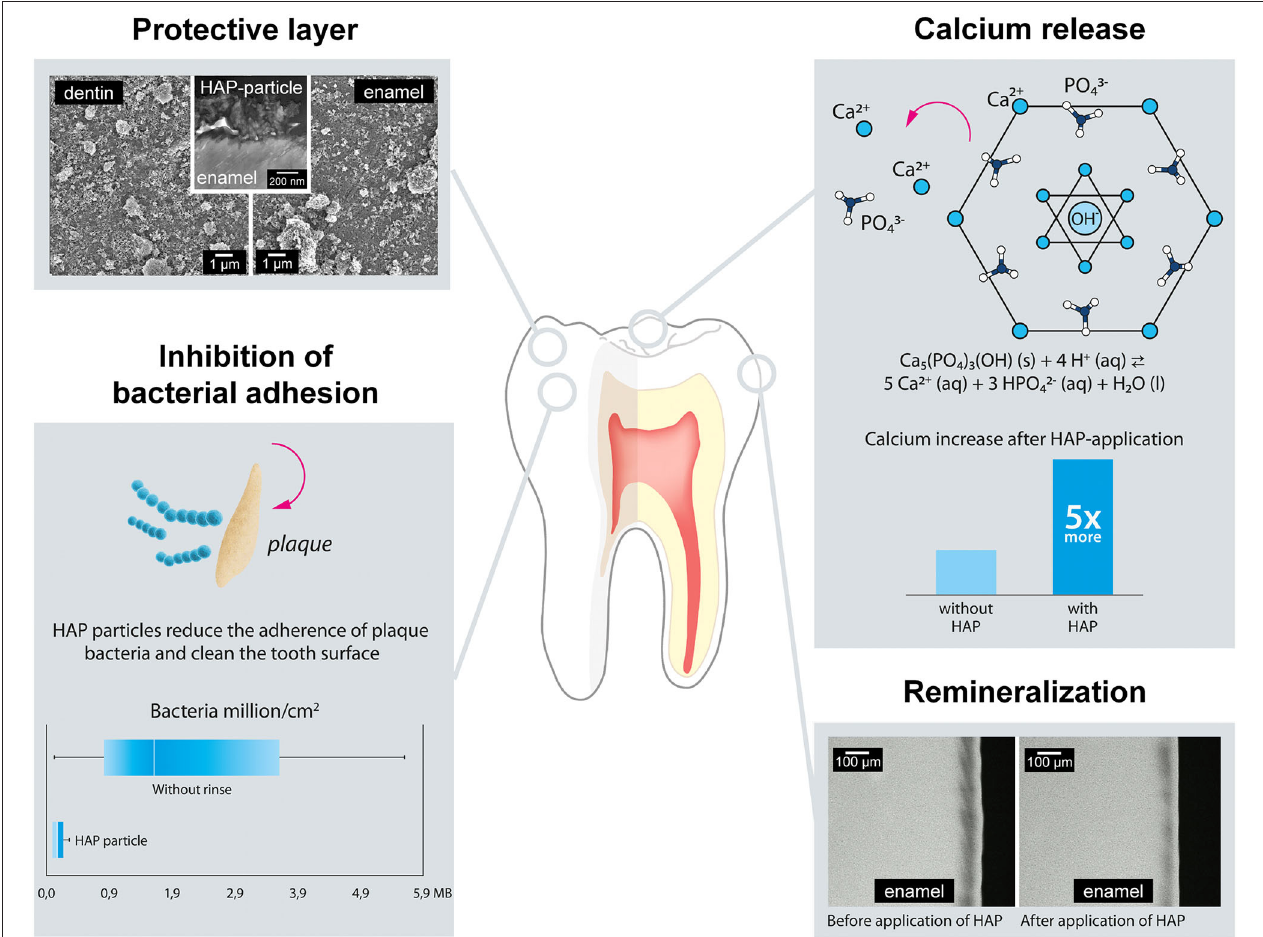
FIGURE 1 | Modes of action of Hydroxyapatite (HAP) with respect to caries prevention and remineralization. HAP forms a protective layer on the tooth-surface. HAP is also known to be a calcium source. Studies have shown that HAP-particles reduce the dental biofilm adhesion. In terms of remineralization, HAP is able to homogenously remineralize